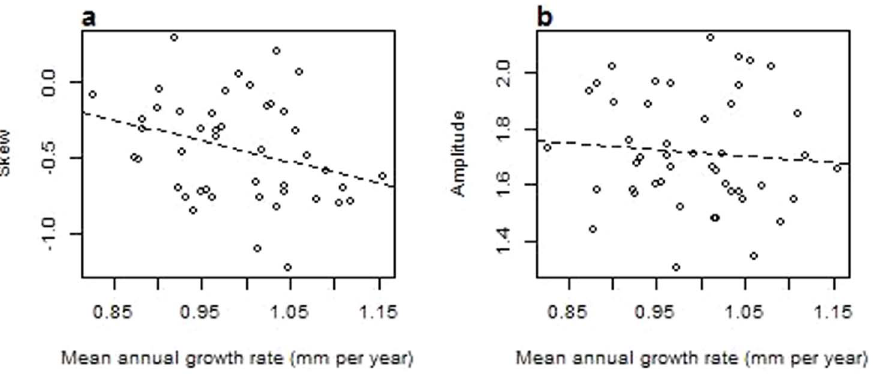
Figure 3. The relationship between the average site-wide mean annual growth rate and a) the symmetry of the maximum temperature around the mean (skew) and b) the amplitude of the scattering (standard deviation).